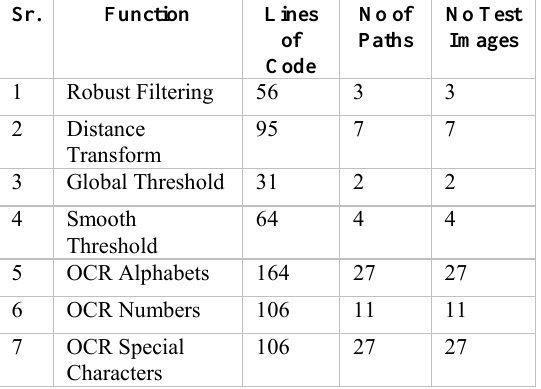
Table 2 Results of Modules of OCR